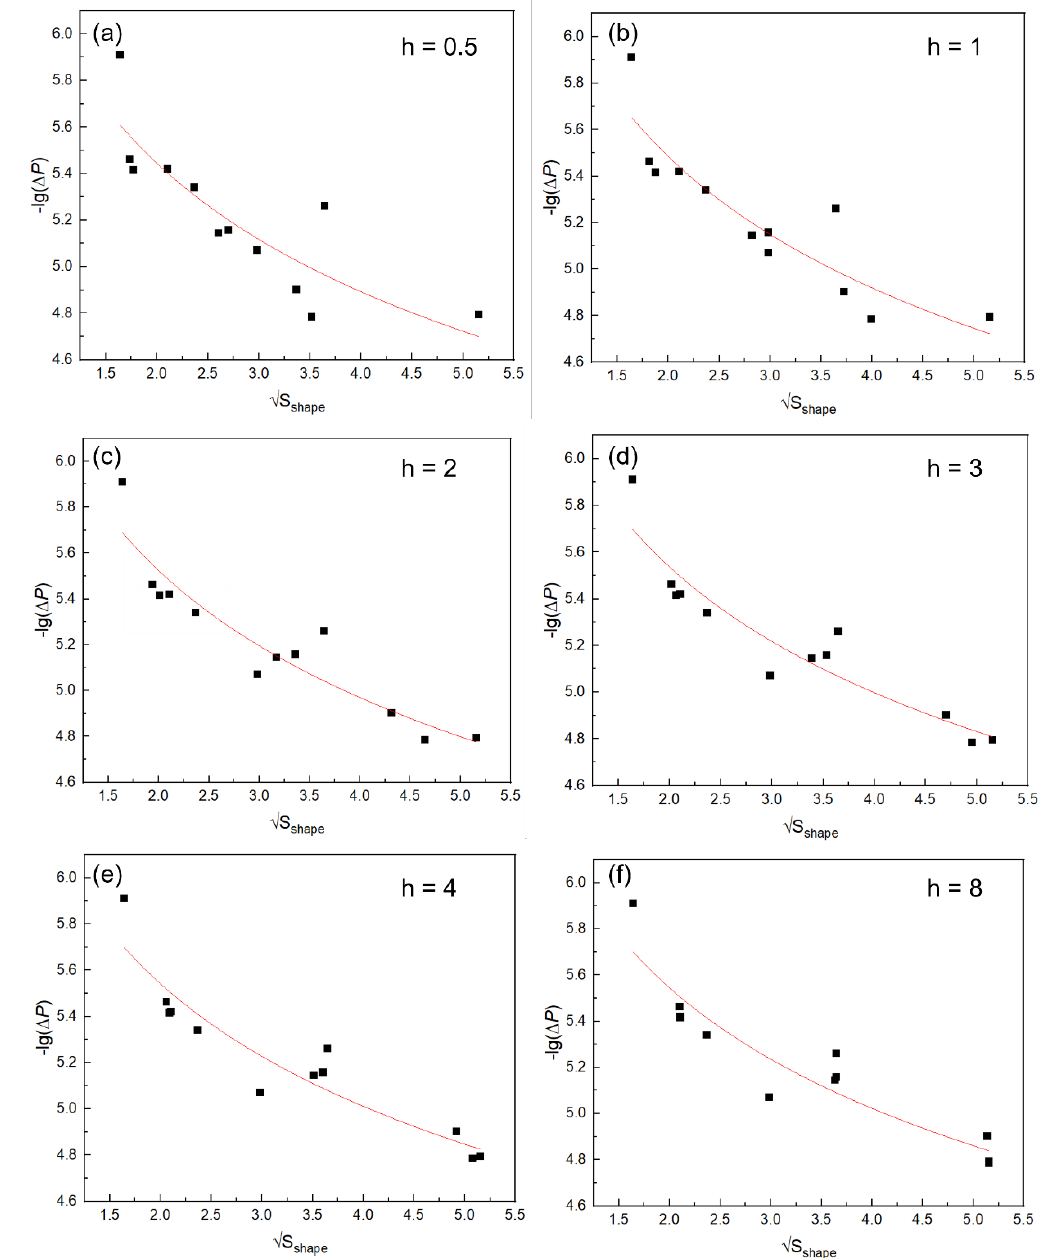
Figure 10. Representative calibration results of Equation (16) with different values of h : ( a ) h = 0.5; ( b ) h = 1; ( c ) h = 2; ( d ) h = 3; ( e ) h = 4; ( f ) h = 8.